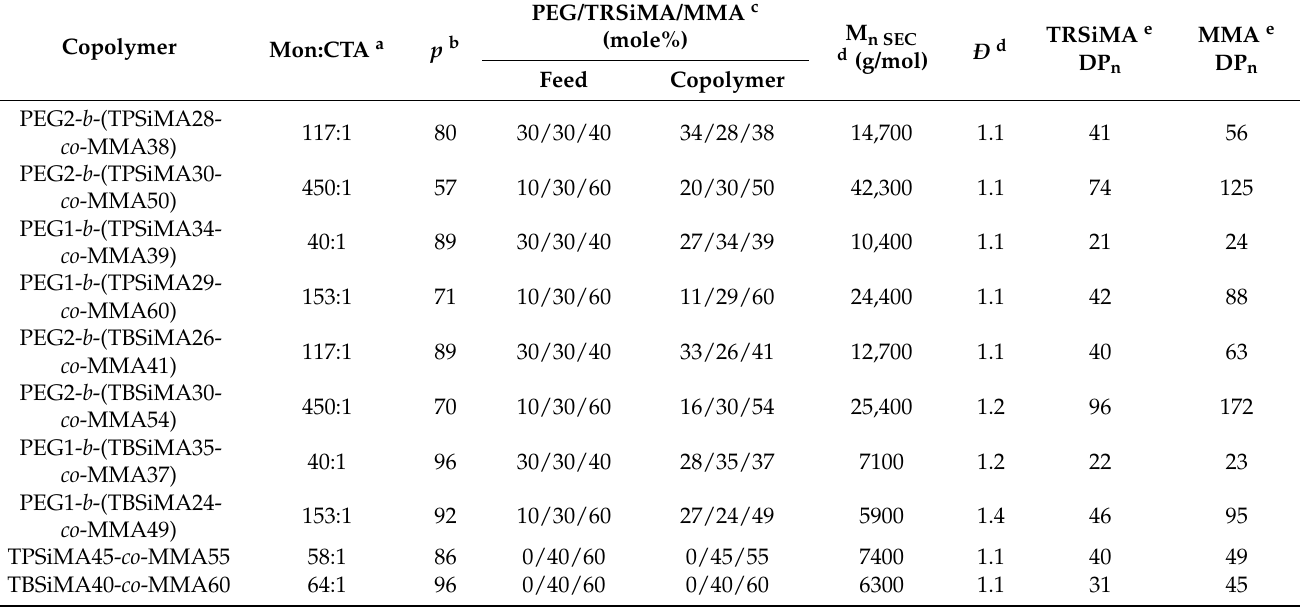
Table 1. Reaction conditions for RAFT block copolymerization and characteristics of TRSiMA-based